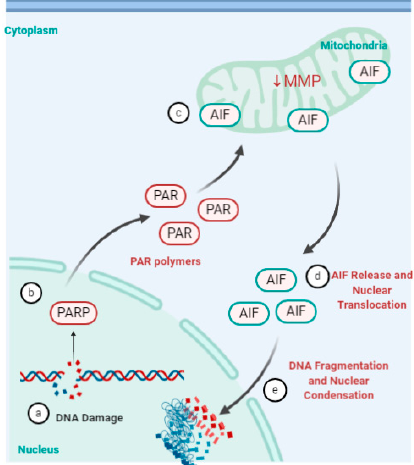
Figure 5. Parthanatos pathway. (a) Severe or prolonged DNA damage, oxidative stress, hypoxia, hypoglycemia or inflam- mation (b) triggers the activation of the enzyme poly(ADP-ribose) polymerase (PARP). (c) This triggers a series of cytotoxic effects such as NAD+ and ATP depletion and accumulation of poly(ADP-ribosyl)ated proteins (PAR) at the mitochondria. (d) PAR bind to apoptosis-inducing factor (AIF), decrease in mitochondrial membrane potential (MMP) and prompts re- lease of AIF into the cytoplasm. (e) AIF then translocates to the nucleus and mediates large-scale DNA fragmentation and chromatin condensation [91–93,96] . Created using Biorender accessed on 31 January